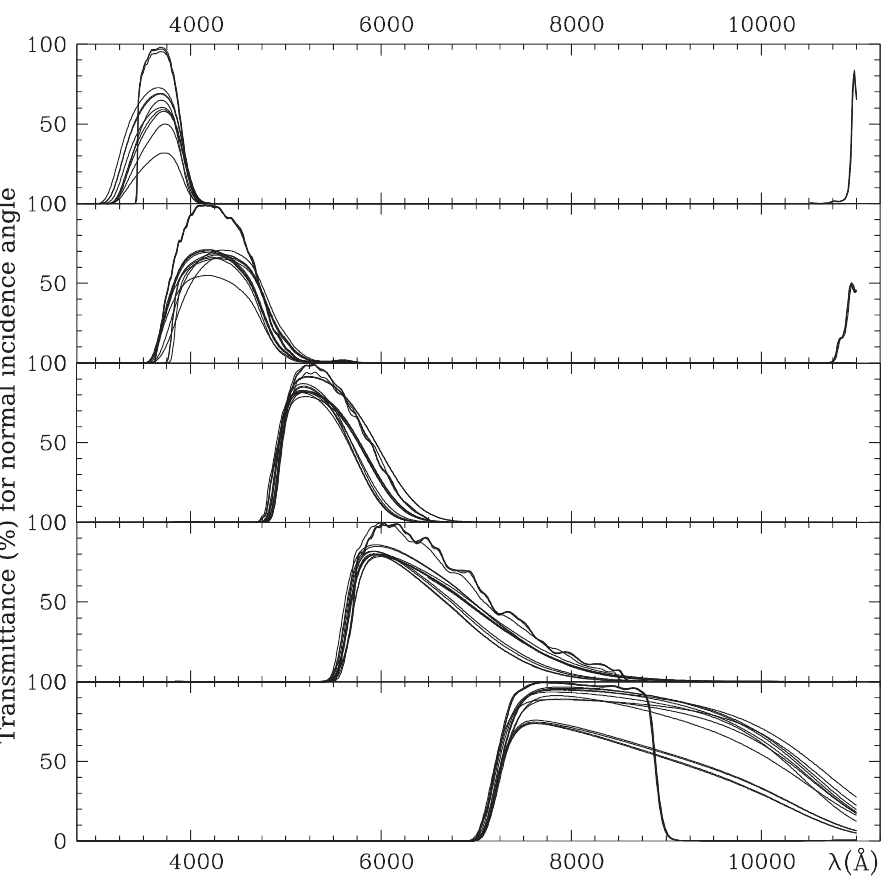
Fig. 1. The transmittance curves (for 90 ◦ incidence angle) measured for a sample of the photometric filters in use in the ANS Collaboration telescopes.